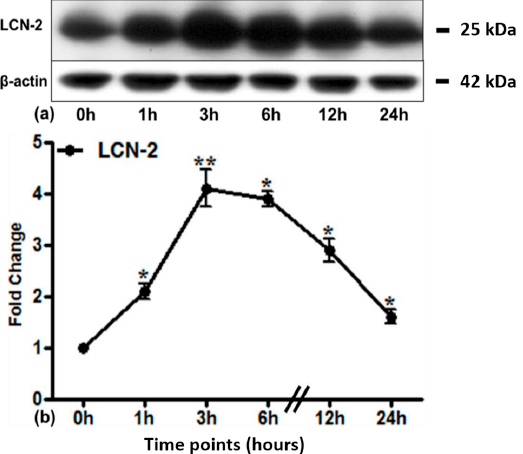
Figure 2. Western blot analysis of LCN2 (25 kDa) protein in the lung of control and irradiated animals at different time points. β -actin (42 kDa) was used as the loading control ( a ). Densitometric analysis of Western blots was performed to show the changes in protein expression of LCN2 ( b ). Results are shown as fold change ± SEM (* p ≤ 0.05, ** p ≤ 0.005, n = 3).